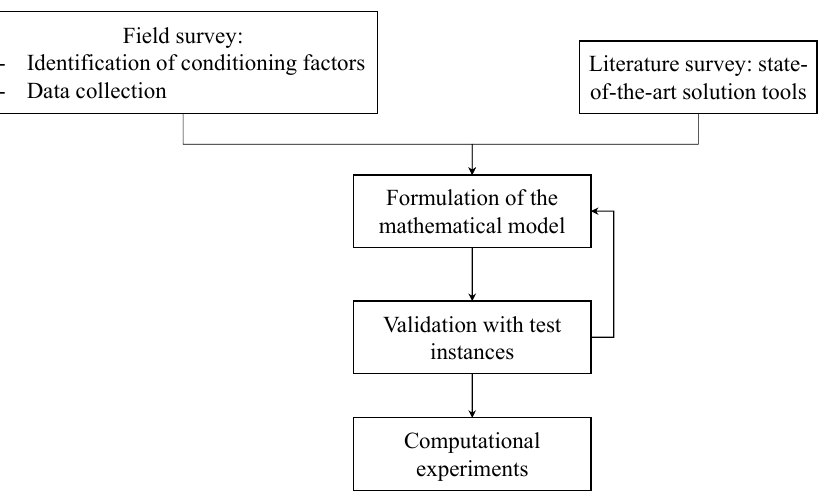
Figure 2. Flowchart of the proposed method. Table 1. Comparison of main problem features addressed in this study and in previous related